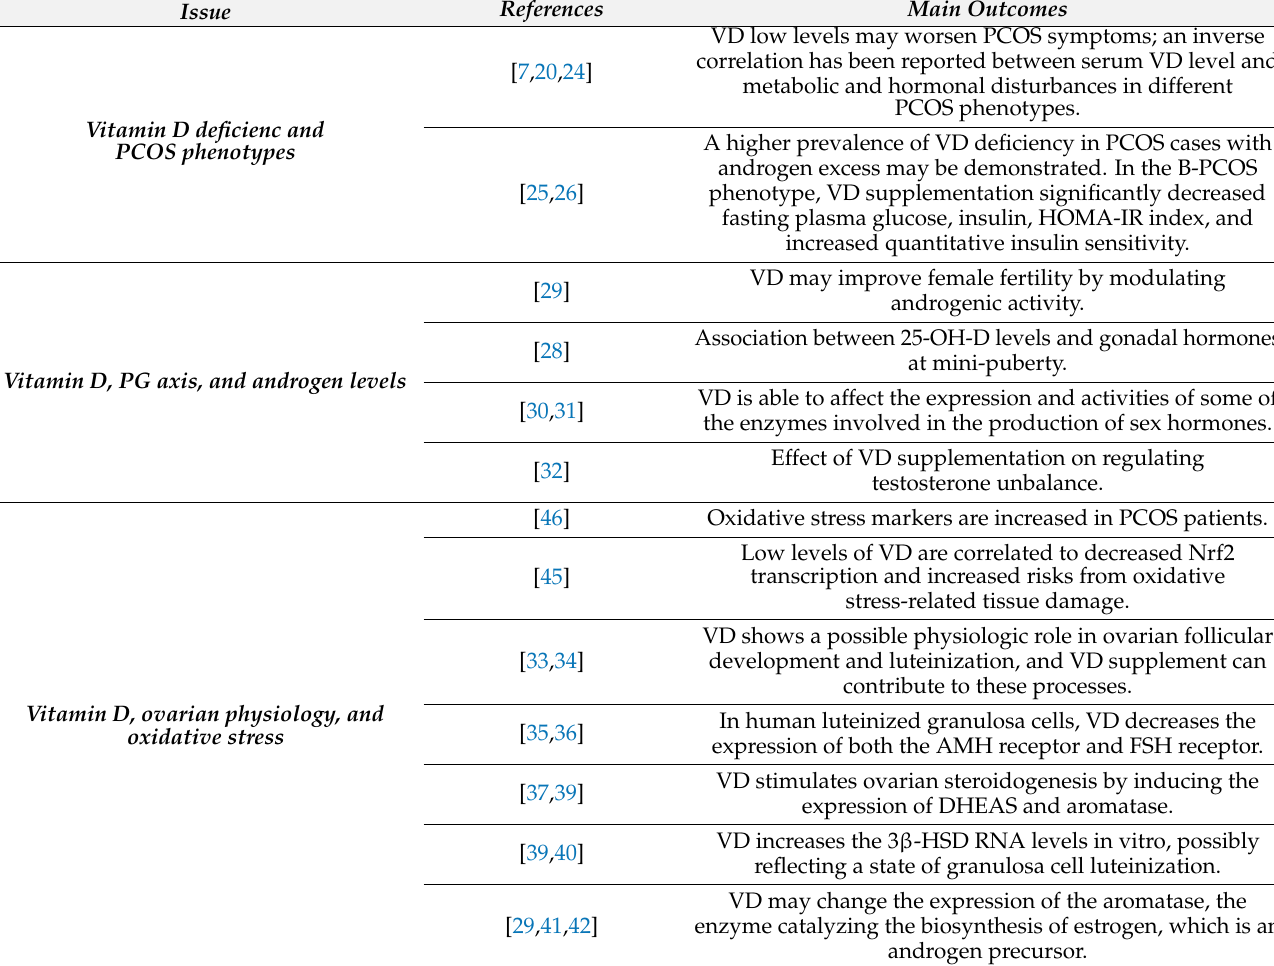
Table 1. Summary of observational